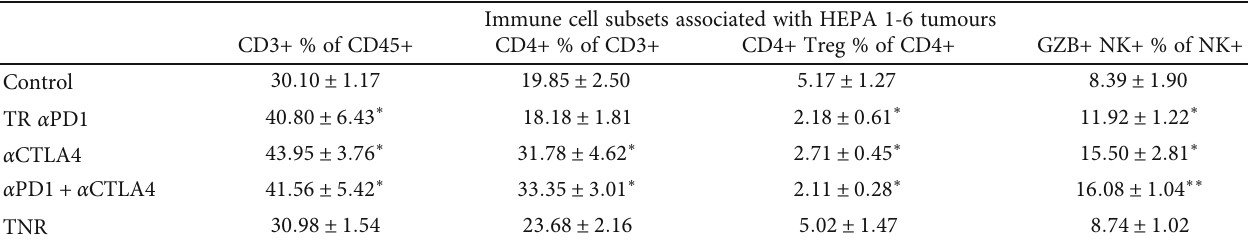
Figure 3: Multicolour fl ow cytometry analysis of HEPA 1-6 tumour-associated immune cells after treatment. Percentages of (a) CD3+ T cells relative to CD45+ cells, (b) CD4+ TILS relative to total CD3+ T cells, (c) CD4+ Treg cells relative to total CD4+ cells, and (d) GZB + NK+ cells relative to total NK+ cells. Data are shown as individual values with mean ± S : D : and are representative of n = 4 − 5 mice/ group. ∗ P < 0 : 05 ; ∗∗ P < 0 : 01 compared to TNR. Table 2: Table showing HEPA 1-6 tumour in fi ltrating immune cells after completion of ICI treatment. Data are shown as mean % of cells ± S : D : and are separated into control, treatment responders (TR), and treatment nonresponders (TNR) and are representative of n = 5 − 10 mice/group, ∗ P < 0 : 05 ; ∗∗ P < 0 : 01 , comparing TR to